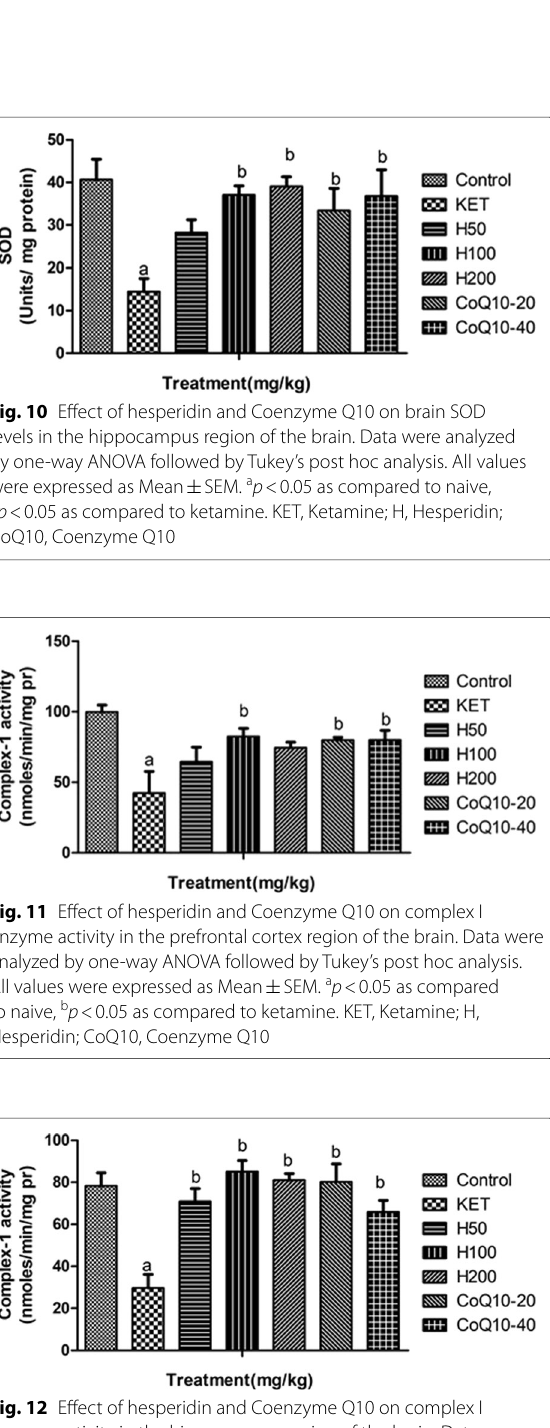
prefrontal cortex and hippocampus regions as compared to the naïve group. Further, treatment with hesperidin (100 mg/kg) and coenzyme Q10 (20 and 40 mg/kg) for